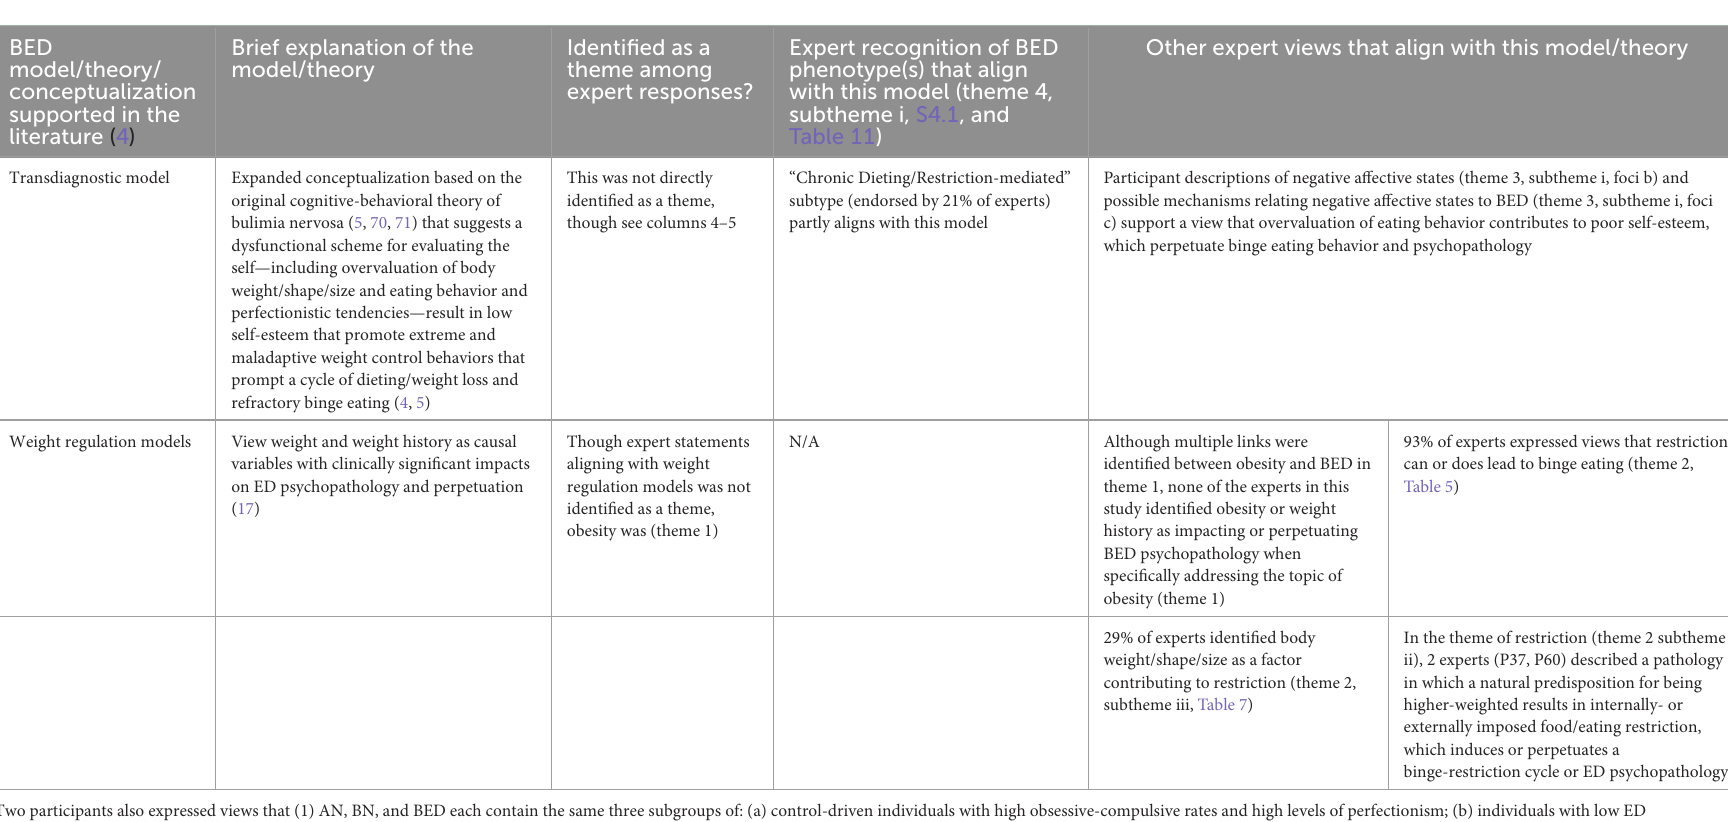
Brief explanation of the model/theory